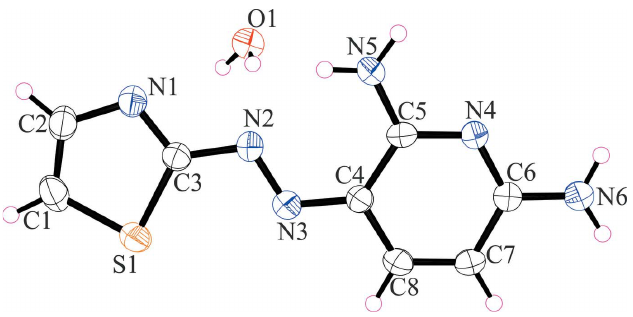
Figure 1 The molecular structure of the organic entity and the water molecule in compound (I), with the atom labelling and displacement ellipsoids drawn at the 50% probability